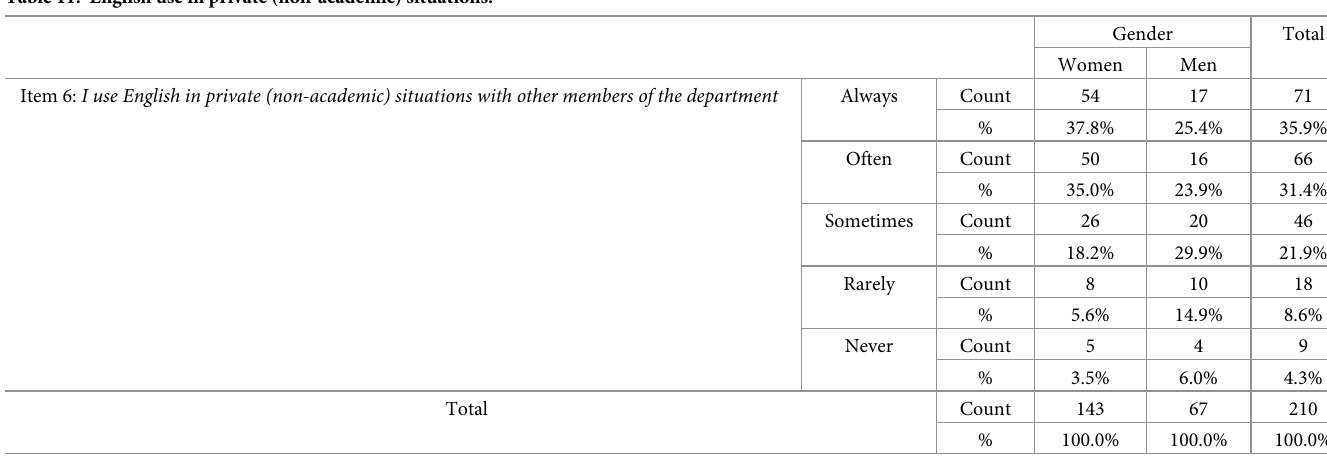
Table 11. English use in private (non-academic)